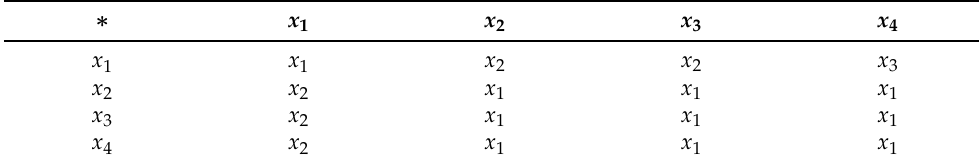
Table 2. A quasi-cancellative CA-groupoid of Example 2.